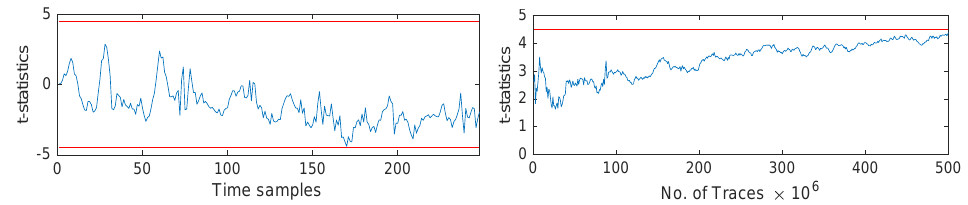
Figure 17: Multivariate second-order non-specific t -test results, clocks ( t, t + 4), with 500 million measurements for two composed DOM-indep multiplications ( d = 2) based on GF (2 4 ) multipliers with all registers applied, arranged like